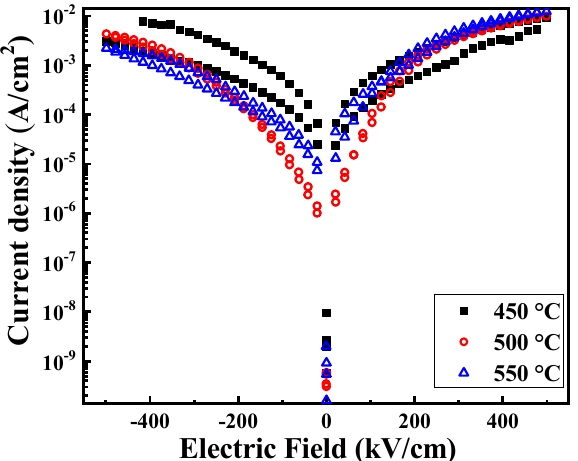
Figure 5. Leakage current densities of BFO thin films annealed at various temperature in an air